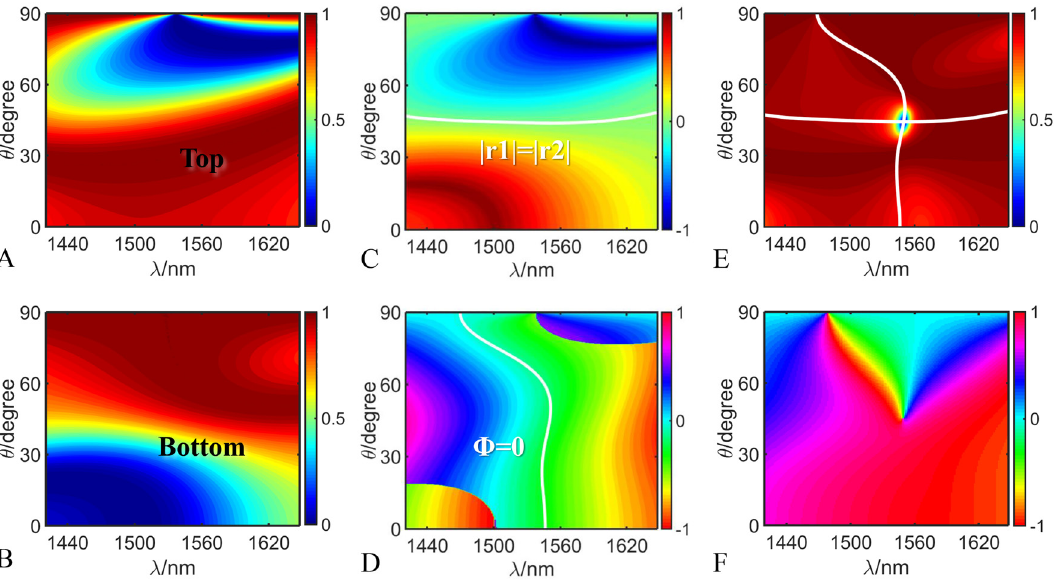
Figure 3: Narrow-frequency sharp-angular filtering explained by two highly reflective meta-grating (MG)s ’ complementary spectra. (A, B) Reflectivity contours of the top and bottom sub-gratings as a function of wavelength and incident angle. ( t g1 b = 0.8 Λ , t g2 = 1.0 Λ , Λ = 568 nm).(C)Thecontouroftopandbottomsub-gratings ’ re fl ectionamplitudedifferencesasafunctionofwavelengthandincidentangle.Thewhite curveindicatesthewavelengthandincidentanglethatsatisfythemagnitudecriterion( | r 1 | = | r 2 | ).(D)Phasefactor( Φ )contour(theunitofcolor bar is π ) as a function of wavelength and incident angle. The white curve indicates the wavelength and incident angle that satisfy the phase criterion( Φ =0).( t s =1.0 Λ ).(E)Re fl ectivitycontourofthenarrow-frequencysharp-angular fi lterasafunctionofwavelengthandincidentangle. Thewhitecurvesin(C)and(D)aresuperimposedonit.(F)Re fl ectionphasecontourofthenarrow-frequencysharp-angular fi lterasafunctionof wavelength and incident angle (the unit of color bar is π